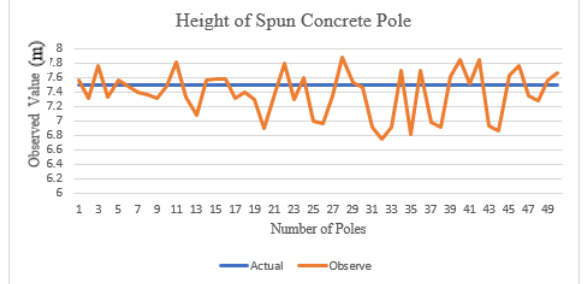
Figure 15 . The Height of Concrete